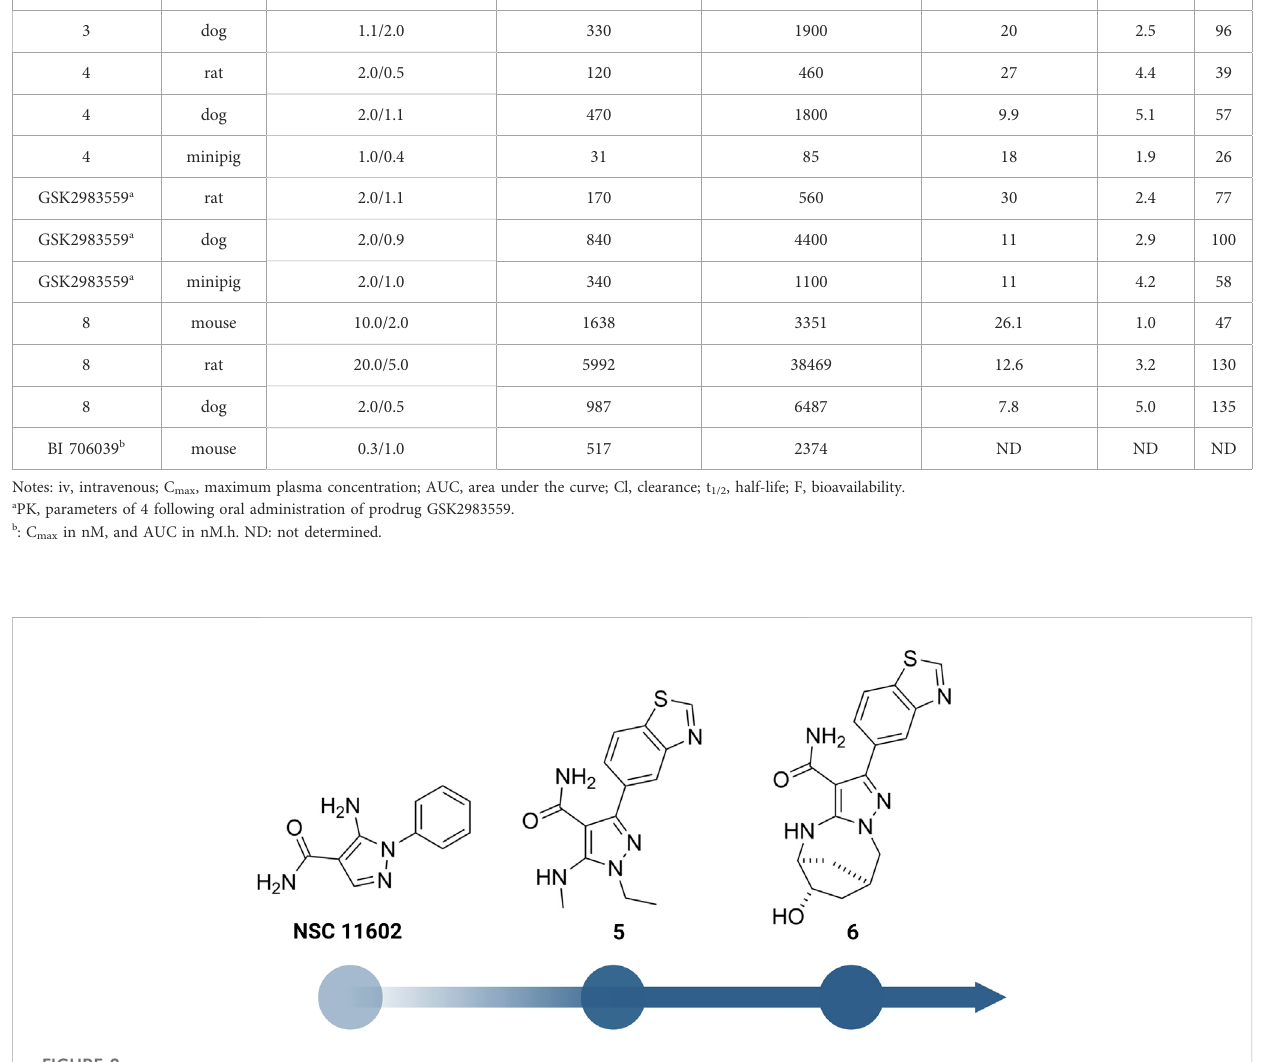
FIGURE 8 Structure optimization of GSK ’ s pyrazole